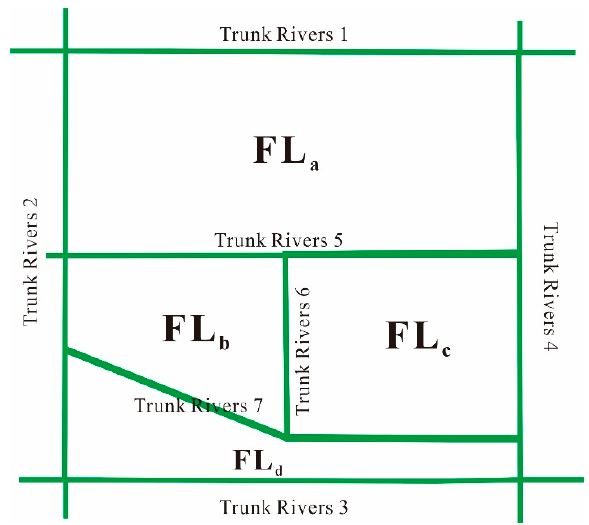
Figure 5. FL (First-Level) catchment division. (The green lines demote the trunk river, based on the trunk river, the first-level catchment can be divided, such as FL a , FL b , FL c , FL d and FL d .).